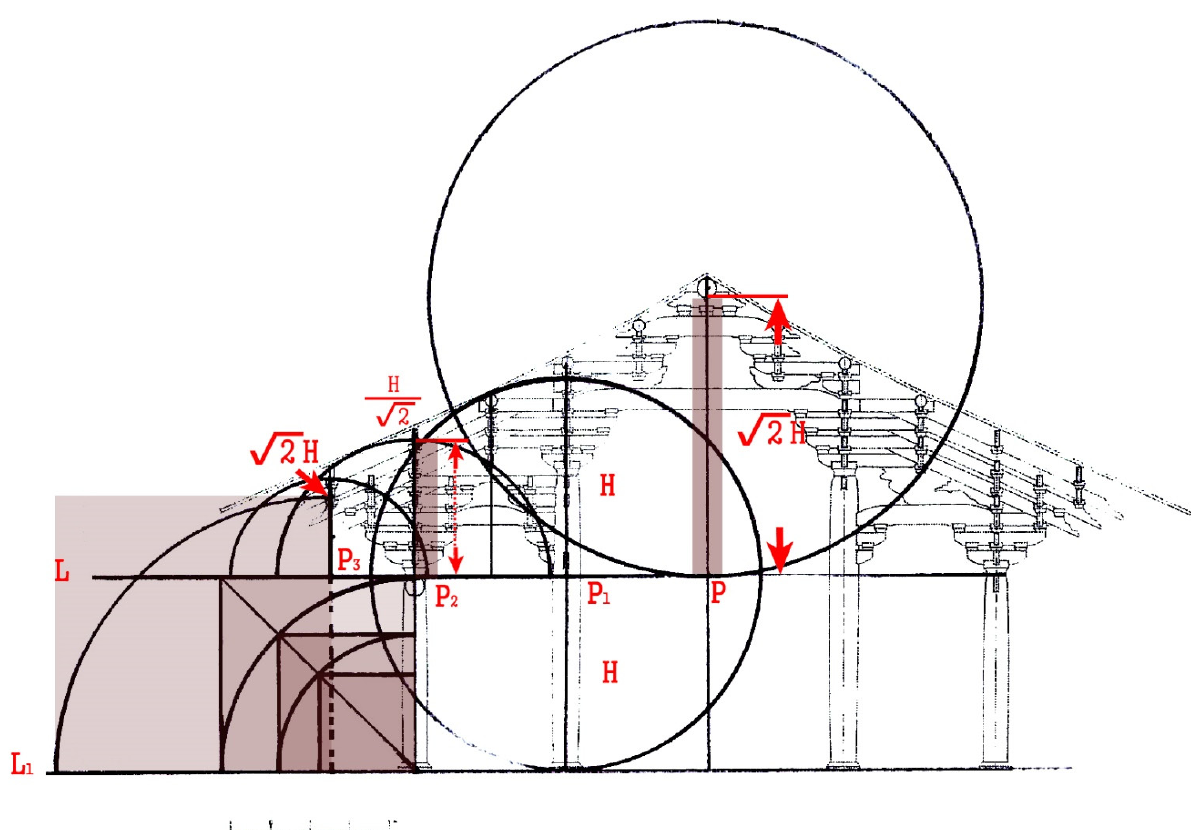
Figure 22. Main Hall of Monastery Hualinsi. Proportional analysis of the sectional elevation (H = eave column height, Ø = circle diameter), Adapted from Wang et al. (2011, p. 143).